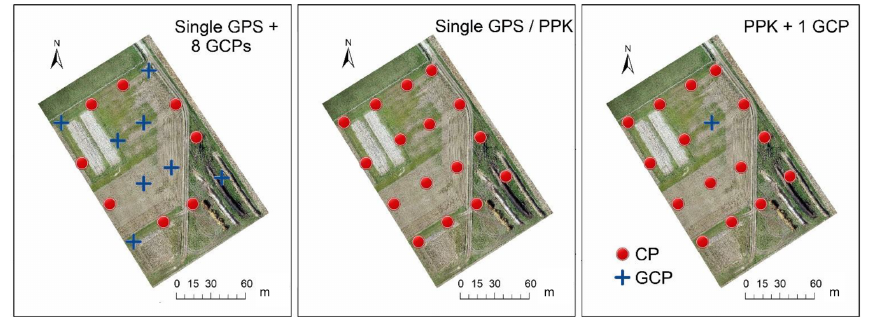
Figure 3. Distribution of GCPs and CPs and illustration of the different georeferencing configurations: single GPS, single GPS + 8 GCPs, PPK, PPK + 1 GCP . Note: cross-validation was implemented in the PPK + GCP configuration; i.e., one single control point was used as a GCP in each